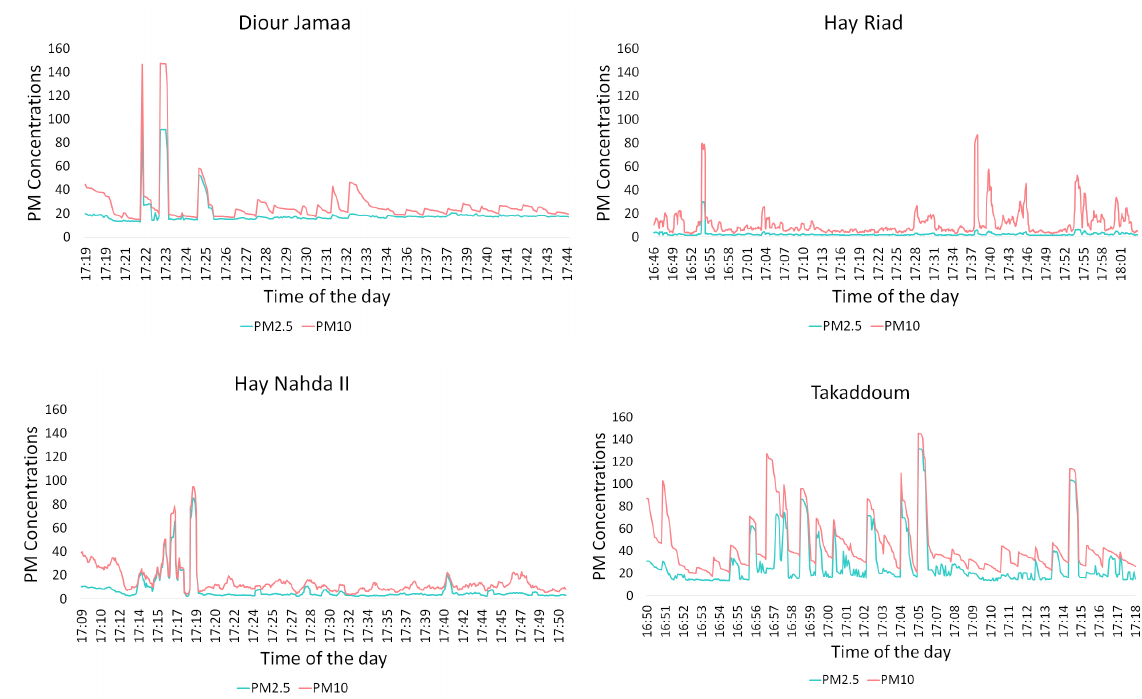
Figure 11. PM 10 and PM 2.5 measurements in µ g/m 3 recorded in four